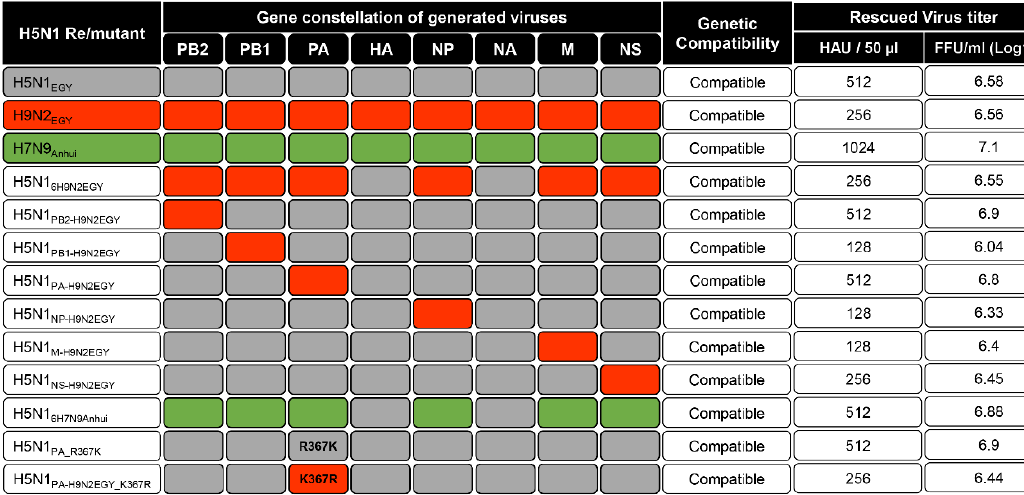
Figure 1. Genetic compatibility between Egyptian H5N1- and H9N2-viruses. The six internal-proteins encoding segments of LPAIV H9N2 EGY , were placed individually and in combination, into the genetic background of HPAIV H5N1 EGY . The gene segments from H5N1 EGY and H9N2 EGY are colored in grey and red, respectively. The six internal-proteins encoding segments from H7N9 Anhui (control) are colored in green. All genetic constellations used in this study were transfected to co-culture of 293T / MDCK-II cells and the rescued wild-type, reassortant and mutant viruses were propagated on embryonated SPF eggs. All genetic combinations were compatible showing variable hemagglutination unit (HAU) and focus forming unit (FFU) titers.